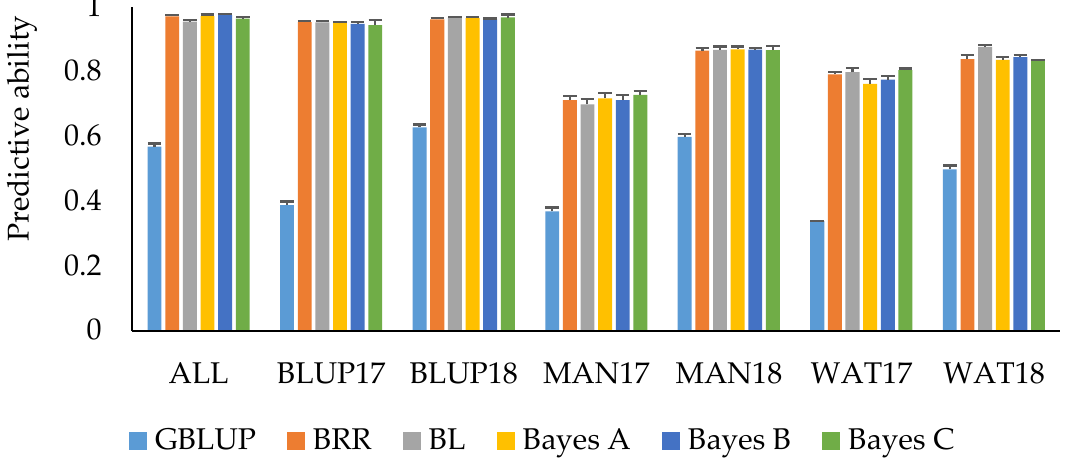
Figure 3. Mean predictive ability for snow mold tolerance across different environments and models. Trait values were adjusted using Bayesian models for IBCF. ALL — BLUP across all environments; BLUP17 — BLUP across 2017 growing season; BLUP18 — BLUP across 2018 growing season; MAN17 — BLUE for Mansfield, WA, for 2017; MAN18 — BLUE for Mansfield, WA, for 2018; WAT17 — BLUE for Waterville, WA, for 2017; WAT18 — BLUE for Waterville, WA, for 2018. BRR — Bayesian Ridge Regression; BL — Bayesian LASSO. GBLUP is a univariate, non-IBCF genomic BLUP model. Bars indicate standard errors.